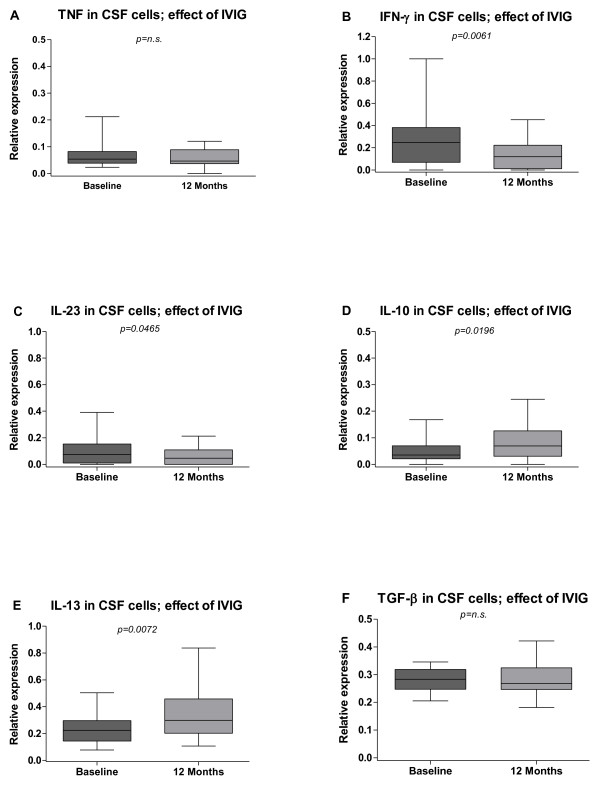
Effects of intravenous immunoglobulin (IVIG) on levels of inflammatory cytokines in cerebrospinal fluid (CSF) cells. The median-based box plots indicate 25th/75th percentiles and whiskers indicate 5th/95th percentiles. Values of statistical significance are indicted (n.s.: non significant).